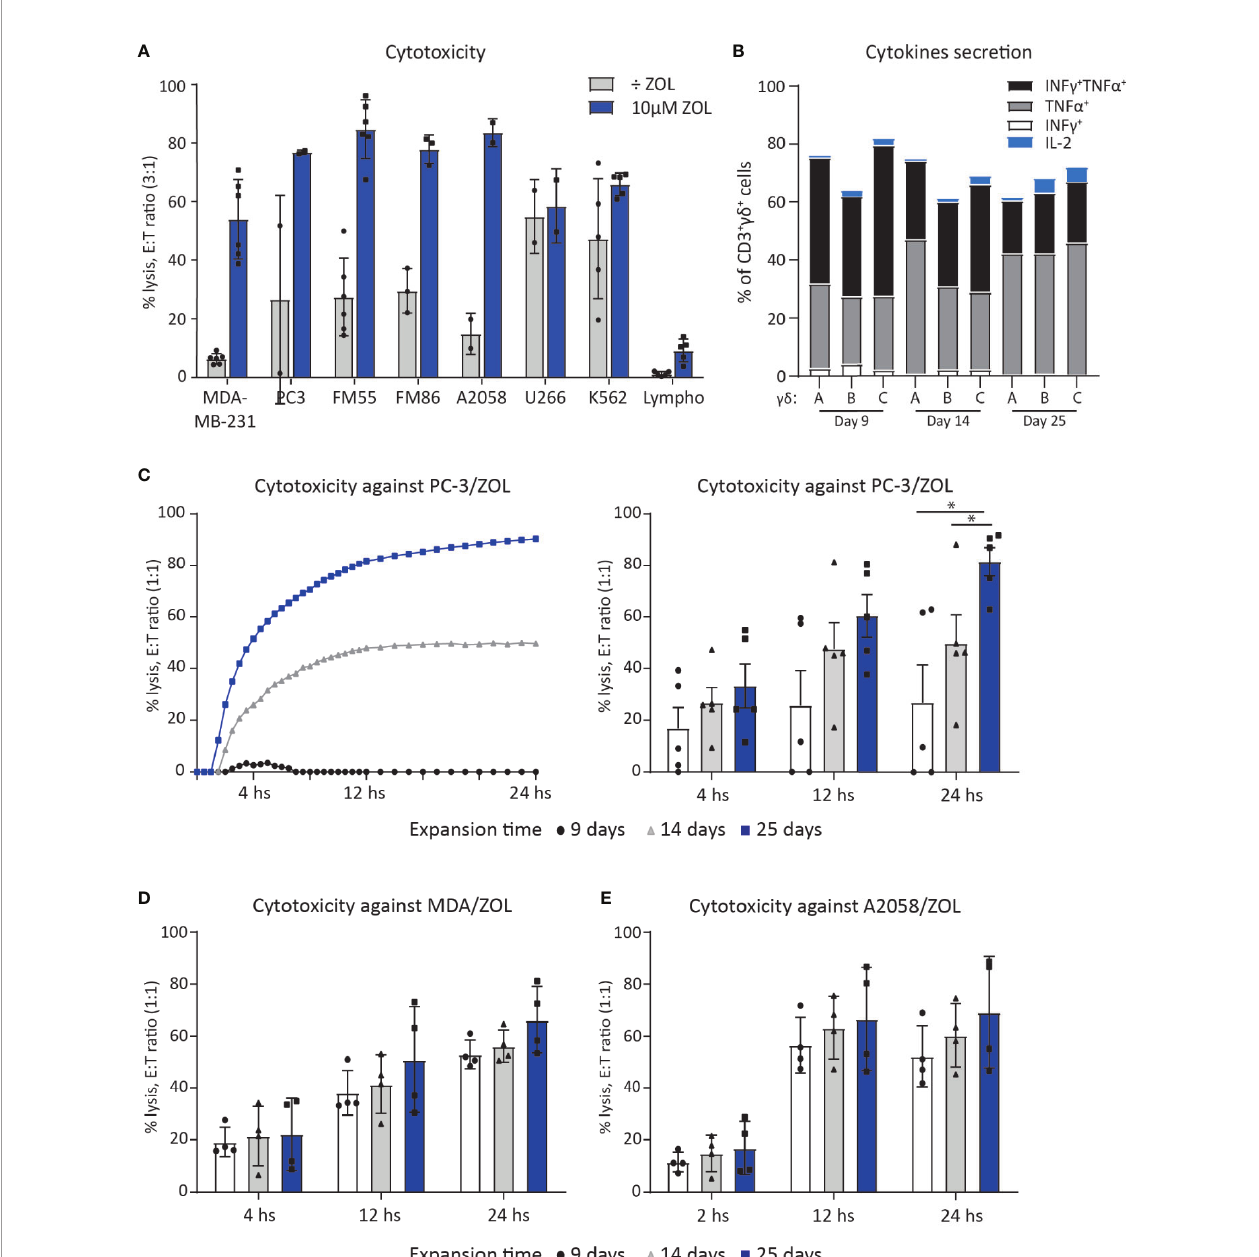
FIGURE 1 | V g 9V d 2 T cell can ef fi ciently kill cancer cells. (A) Chromium release assay (4 h) was used to test V g 9V d 2 T cell ability to kill cancer cell lines of various origins. V g 9V d 2 T cells were expanded from healthy donors (n =2-6). Effector cell (E:T) Target cell ratio (3:1). Breast cancer cell line = MDA-MB-231, Prostate cancer cell line = PC-3. Melanoma cells lines = FM55, FM86 and A2058. Hematological cancer cells lines = U266 and K562. Lymphocytes (lympho) were thawed and rested overnight prior to the assay. V g 9V d 2 T cell cultures used in these assays had been in culture for 14-30 days prior to the chromium release assays. Purity >90% for V g 9V d 2 T cell cultures was veri fi ed by fl ow cytometry (data not shown, see gating strategy in Supplementary Figure 1A ). (B) Cytokine expression of day 9, 14 and 24 expanded V g 9V d 2 T cells was determined by gating on positive cells in PC-3/ZOL co-cultured with V g 9V d 2 T cells. Gates were set according to